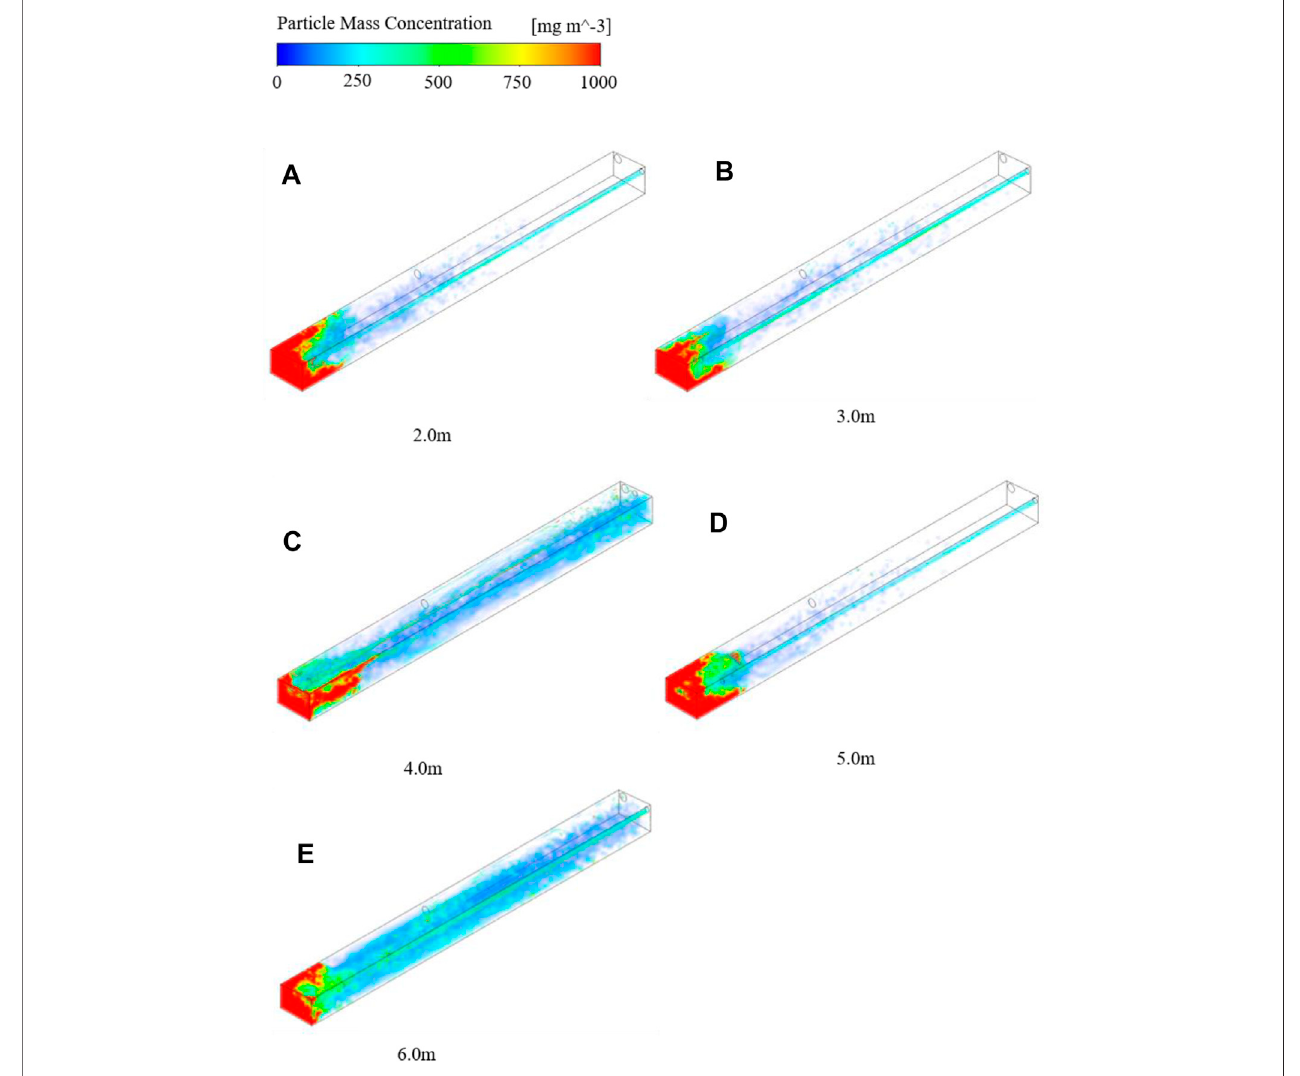
FIGURE 11 | Dust diffusion for different dedusting-air duct distances (no road header): (A) 2.0 m; (B) 3.0 m; (C) 4.0 m; (D) 5.0 m; (E) 6.0 m.